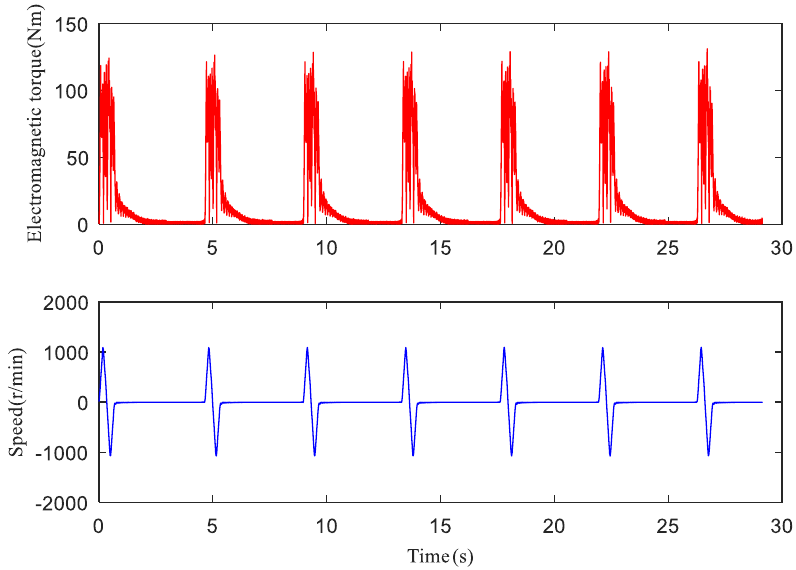
Figure 9. Input and output signal of the test bench when the acceleration time was 0.2 s.